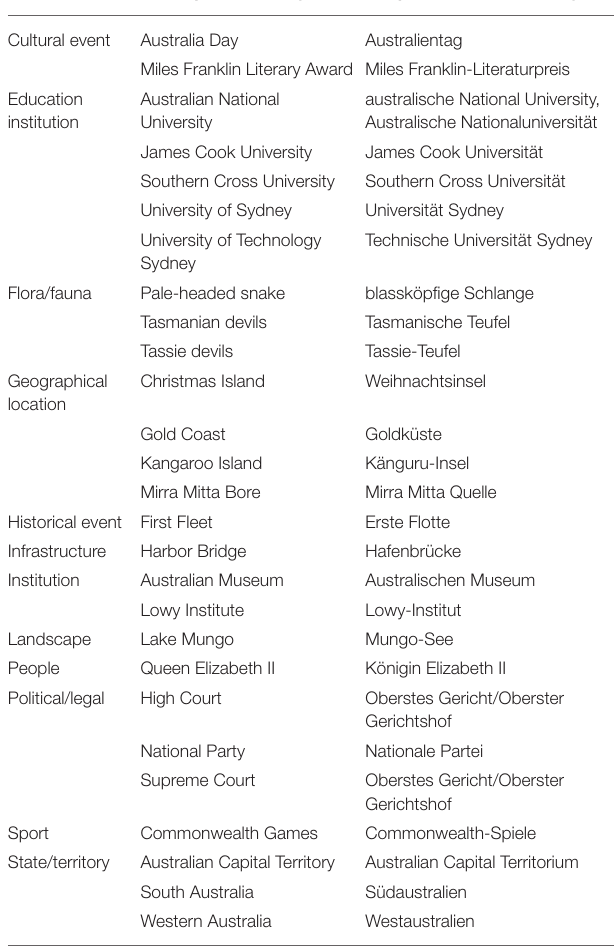
TABLE 4 | Unadapted and adapted forms of the same etymon co-existing in the dataset, per semantic field. Semantic field Unadapted form/etymon Adapted form of same